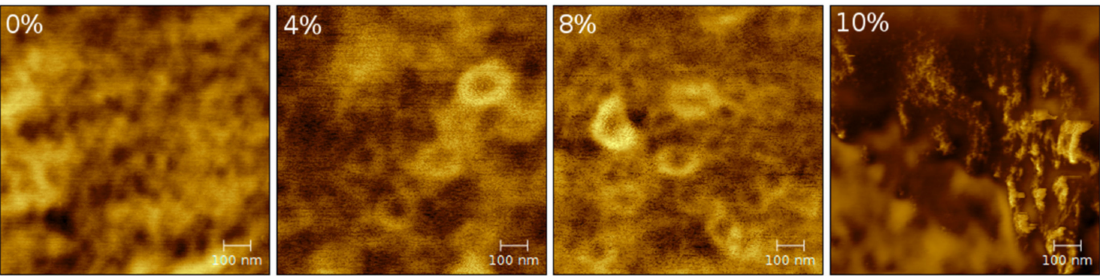
Figure 2. 1 × 1 µ m AFM phase images recorded with selected